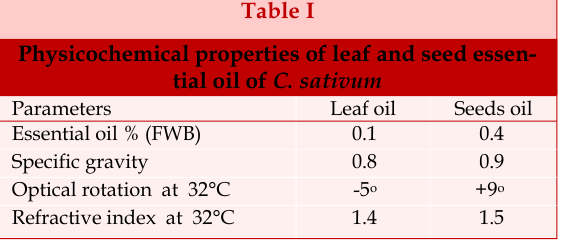
Physicochemical properties of leaf and seed essen- tial oil of C.